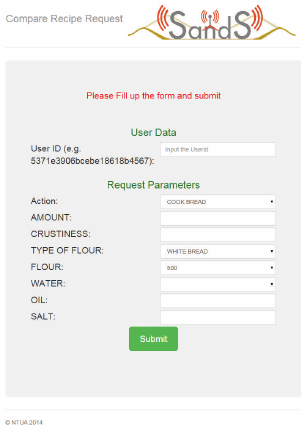
Figure 6: SandS recipe request similarity form.